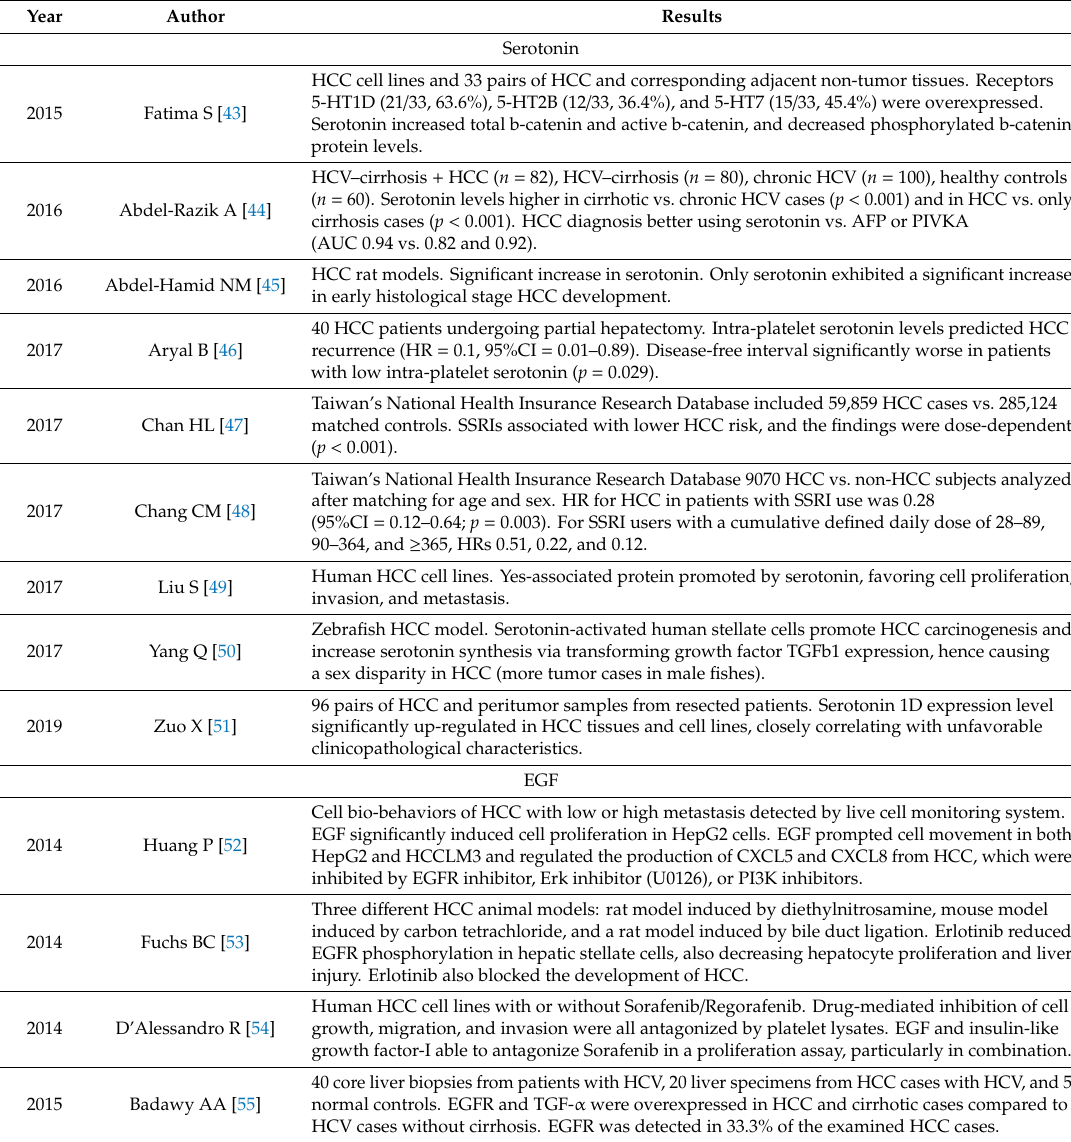
Table 2. Studies focused on the role of serotonin, epidermal growth factor (EGF), and vascular endothelial growth factor (VEGF) in the development of